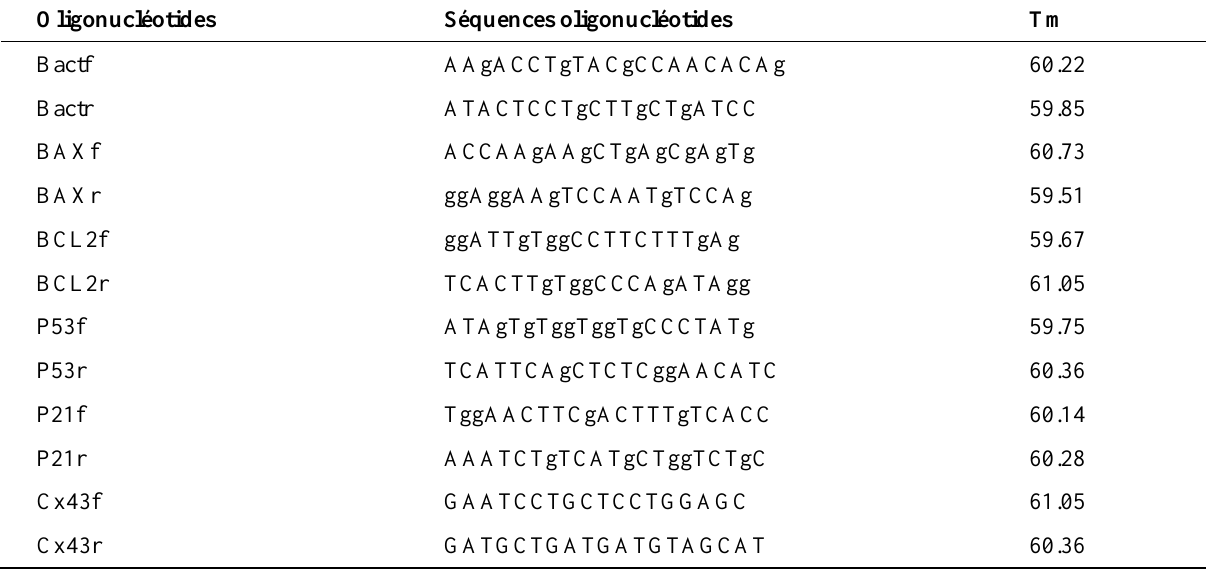
Table 1. Sequences of oligonucleotides used in amplification of genes of